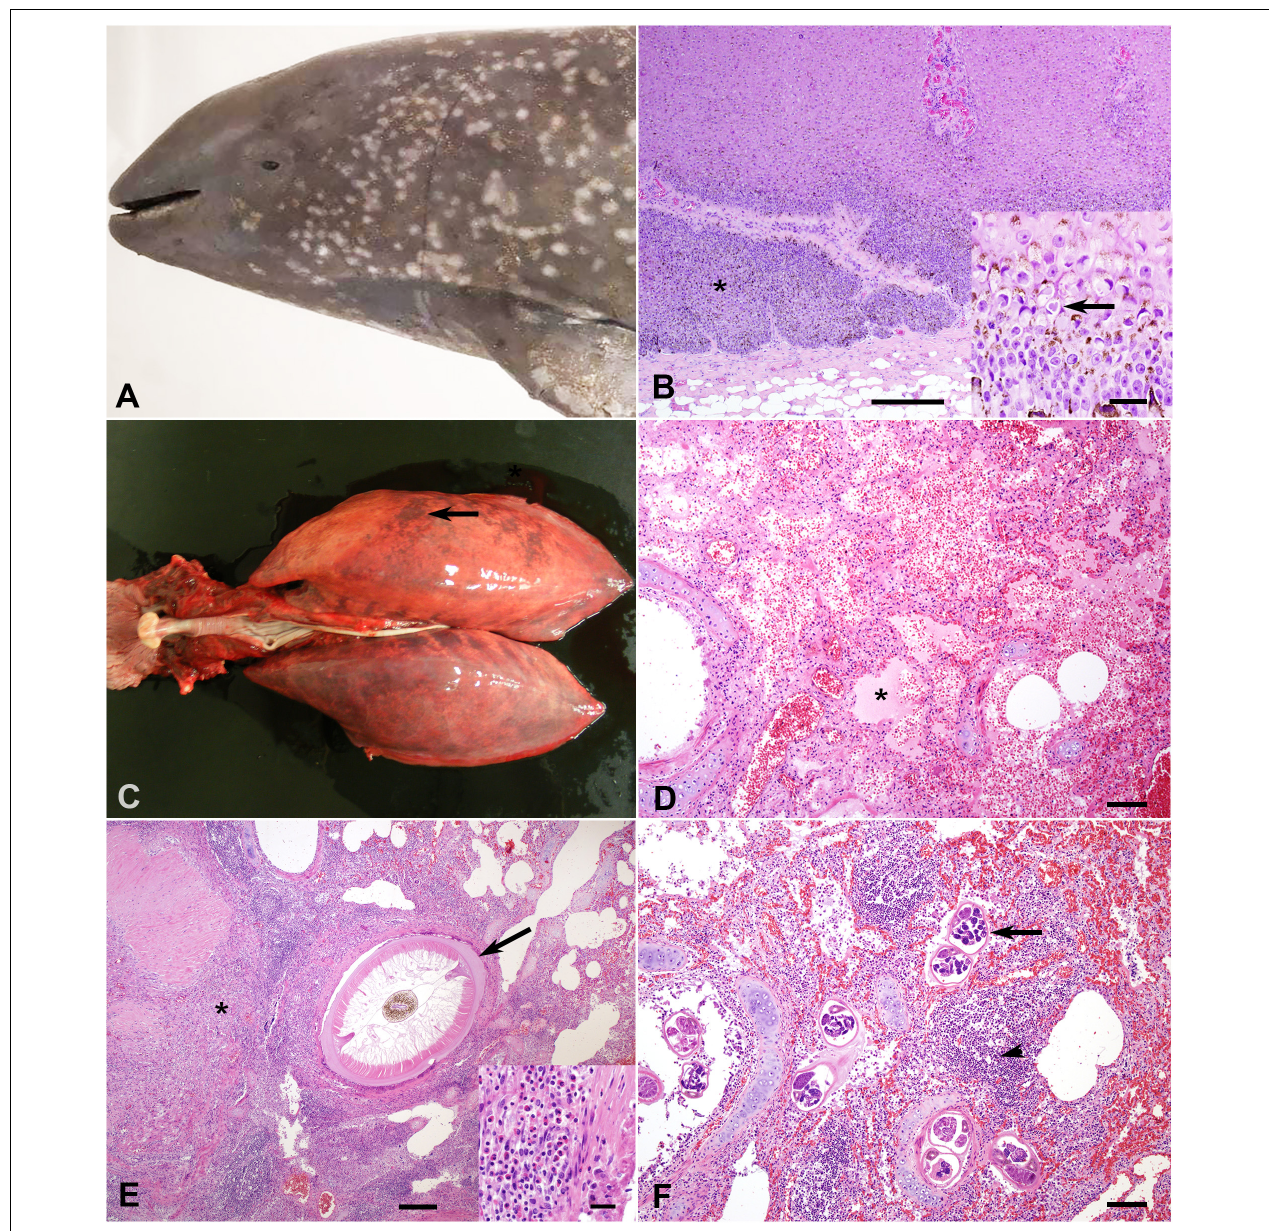
FIGURE 2 | Postmortem findings in Burmeister’s porpoises ( Phocoena spinnipinis ). (A) Multifocal to coalescing tan, circular lesions throughout the skin (tattoo skin lesions) of a subadult porpoise. (B) Histologically, the skin lesions showed in (A) were characterized by stratum basale hyperplasia with hyperpigmentation (asterisk) and vacuolar degeneration of lipokeratinocytes with rare amphophilic intracytoplasmic inclusion bodies (arrow inset). H&E, scale bar = 200 µ m, inset scale bar = 25 µ m. (C) Lung of an adult Burmeister’s porpoise that died most likely due to drowning. Note the uncollapsed lung with mild rib impressions (edema) and multifocal areas of hemorrhage (arrow). (D) Histological section of the lung showed in (C) . Alveoli contain abundant eosinophilic homogeneous material (edema, asterisk) and numerous erythrocytes. H&E, scale bar = 150 µ m. (E) Verminous, eosinophilic bronchopneumonia and vasculitis. A large nematode (most likely Pseudalius inflexus ) (arrow) obliterates a bronchus and numerous eosinophils (inset) obscure peribronchiolar tissues. Adjacent to the nematode section, eosinophilic inflammatory infiltrate obscure a thrombosed large artery (asterisk). H&E, scale bar = 200 µ m, inset scale bar = 30 µ m. (F) Chronic verminous pneumonia. There are several sections of small metastrongyle nematodes (arrow) associated with lymphoplasmacytic inflammatory infiltrates (arrow head). H&E, scale bar = 100 µ m.